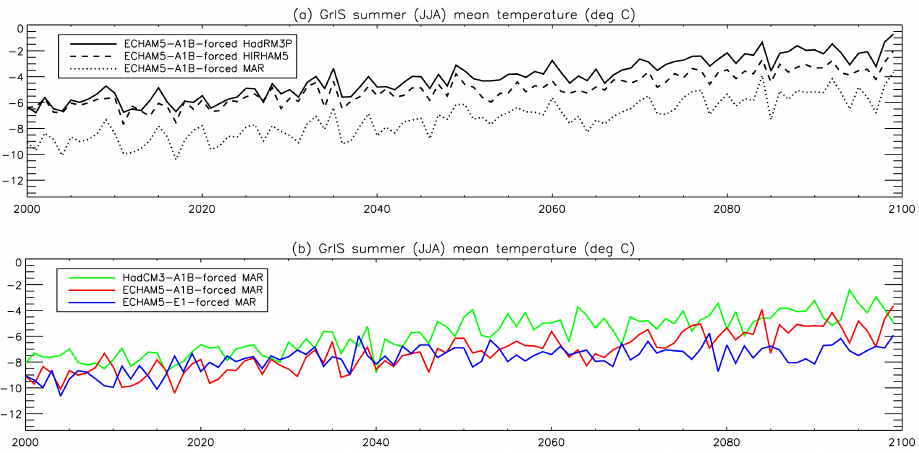
Fig. 10. (a) Time series of GrIS mean summer (JJA) T as , all in ◦ C, for the three RCMs, forced by ECHAM5-A1B boundary conditions. (b) Similar, for MAR, forced by all three sets of future boundary conditions.